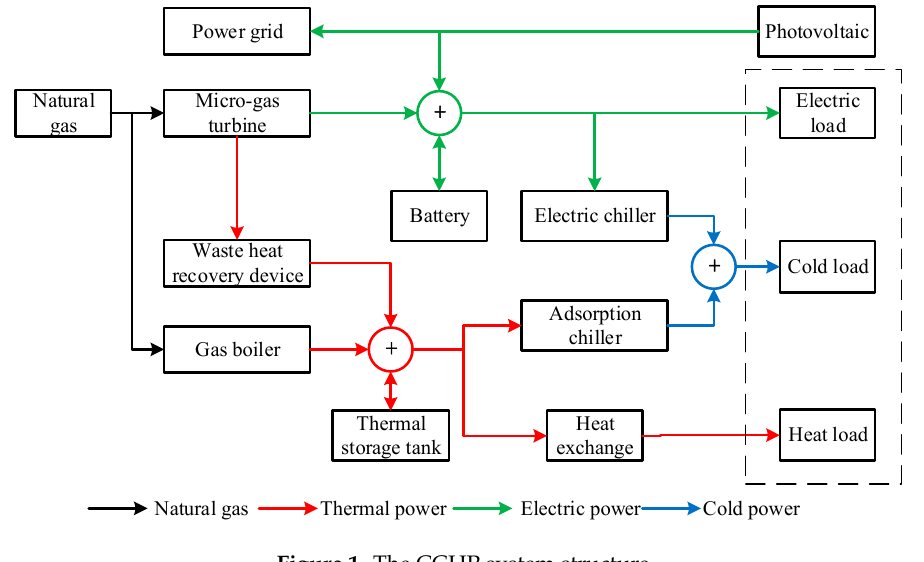
Figure 1. The CCHP system structure.